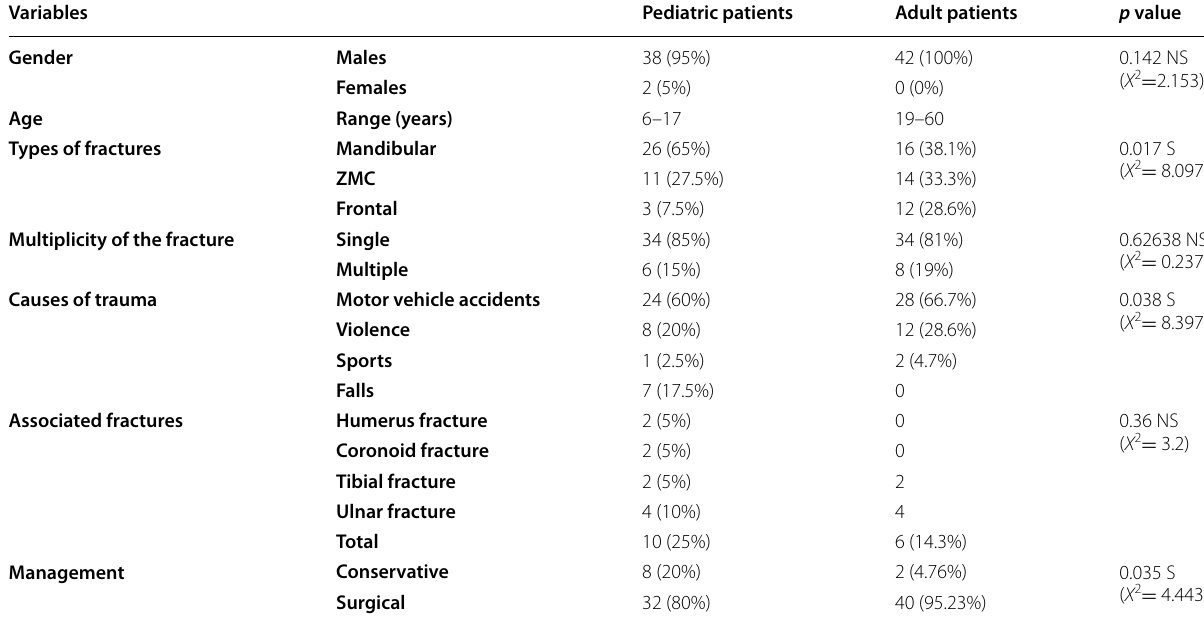
X 2 chi‑square test, NS non‑significant